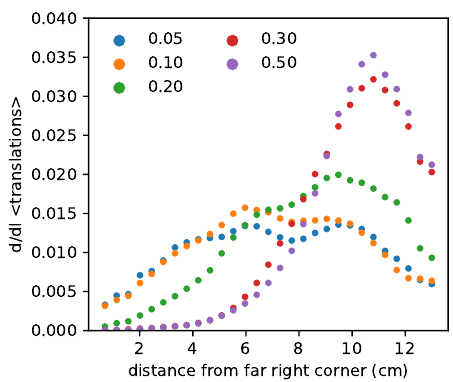
Figure 4. Spatial derivative of the translations in the binned zones for di ff erent values of friction. The binning is performed along an axis parallel to the shear bands. The legend corresponds to the value of friction, µ S .